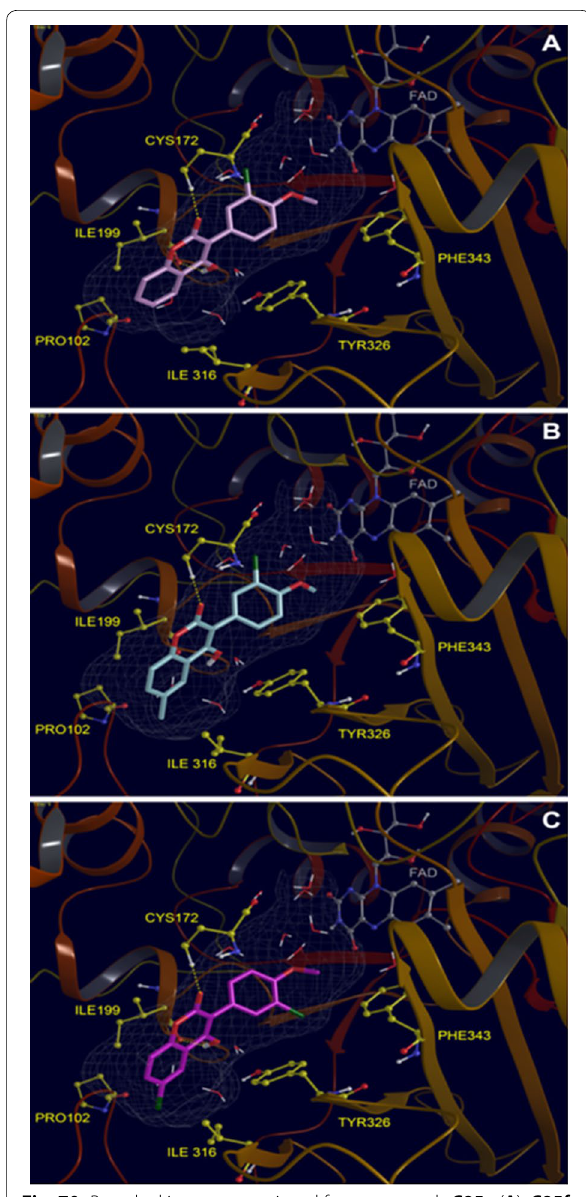
Fig. 70 Best docking poses retrieved for compounds C85e ( A ), C85f ( B ) and C85g ( C ) into the MAO-B (PDB code: 2V60). Coumarins are represented in tube with carbon atoms colored in plum for C85e , turquoise for C85f and purple for C85g